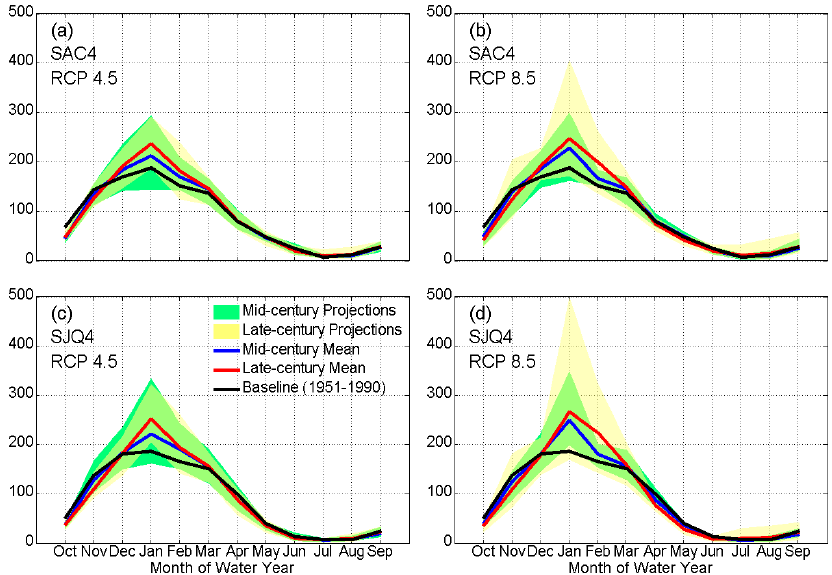
Figure 9. Monthly precipitation projections for Sacramento Four Rivers ( a , b ) as well as San Joaquin Four Rivers ( c , d ) under RCP 4.5 and RCP 8.5 projections, respectively.